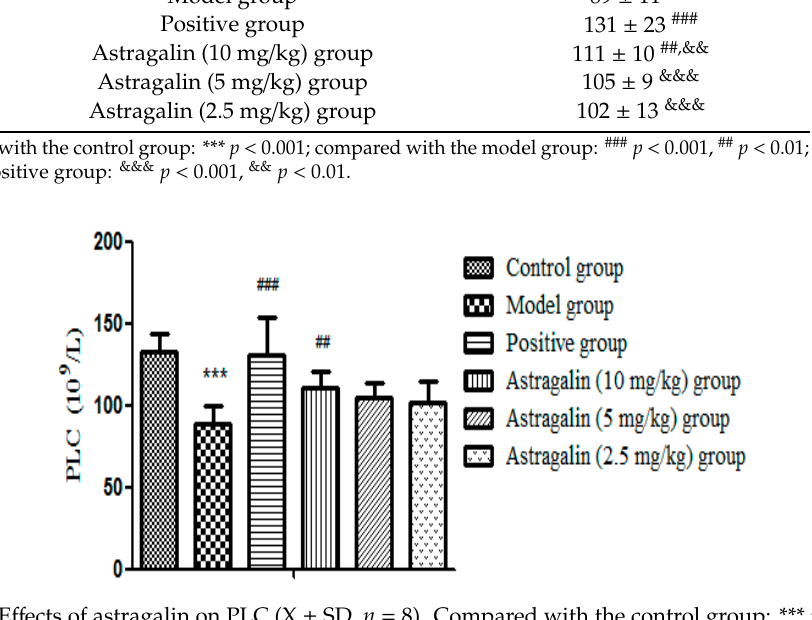
Table 4. Effect of astragalin on PLC (X ± SD, n = 8). Table 4. E ff ect of astragalin on PLC (X ± SD, n = 8).